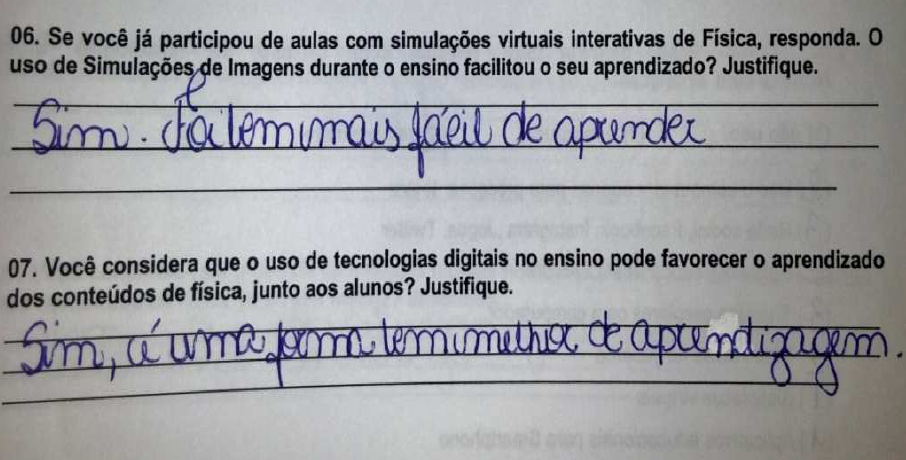
Figure 3 : List of the most interesting means, considered by the students, to learn Physics.